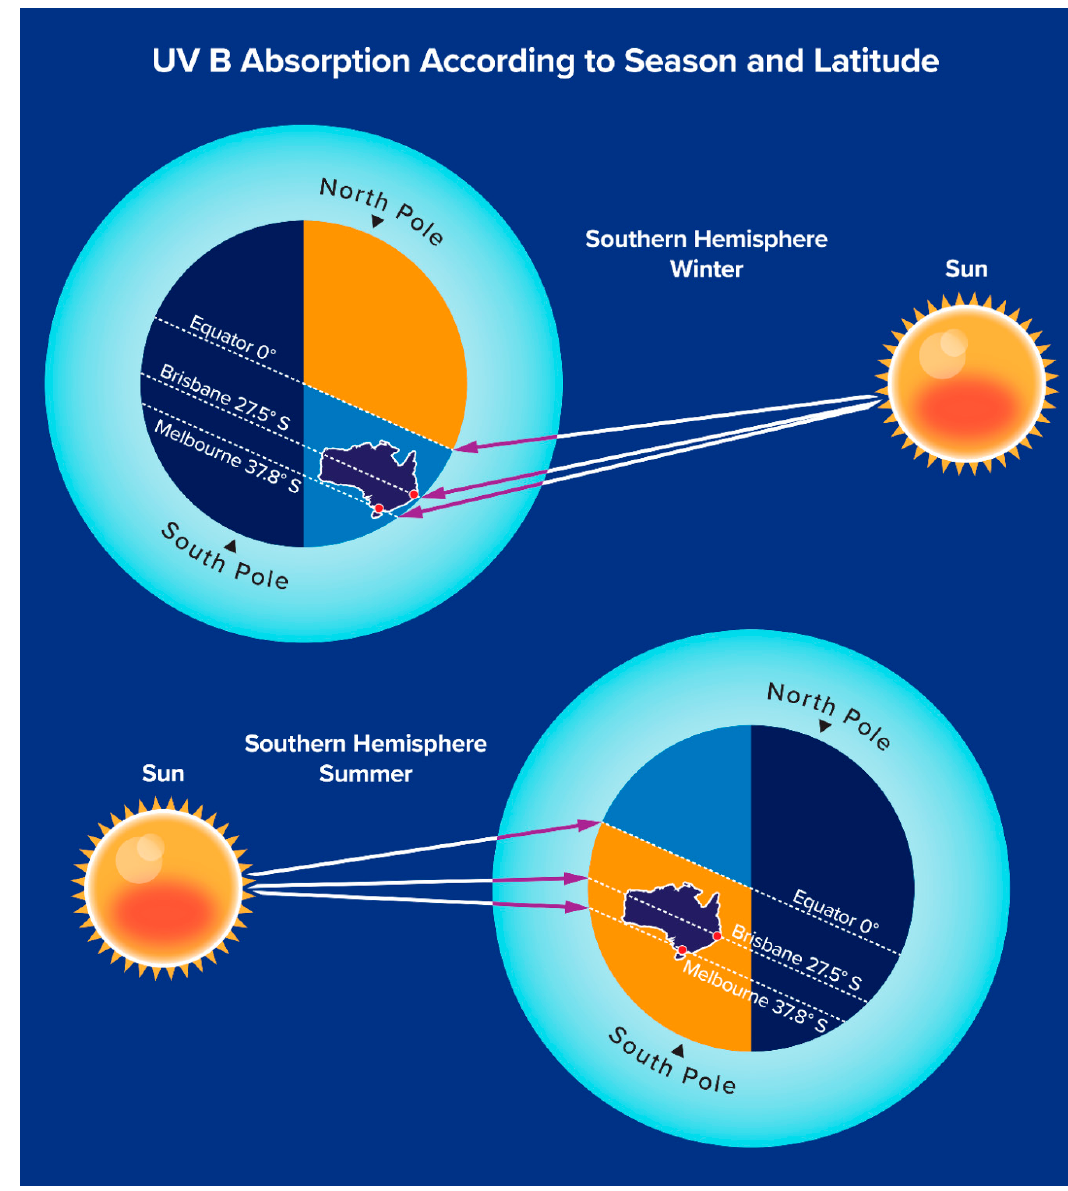
Figure 2. The earth’s atmosphere absorbs increasing amounts of UVB with increasing distance travelled. This schematic diagram (not drawn to scale) illustrates how the distance travelled through the earth’s atmosphere varies according to season and latitude, and that in winter this distance is relatively greater in Melbourne compared with Brisbane .